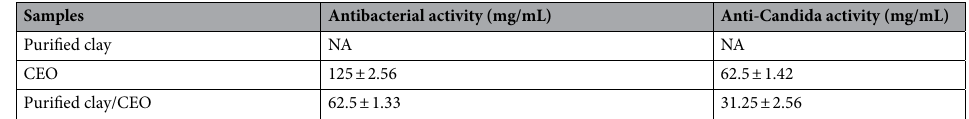
Table 9. Minimum inhibitory concentration tests of purified clay, CEO and Purified clay/CEO against Staphylococci aureus (S. aureus) and Candida. Albicans. NA, not actif.